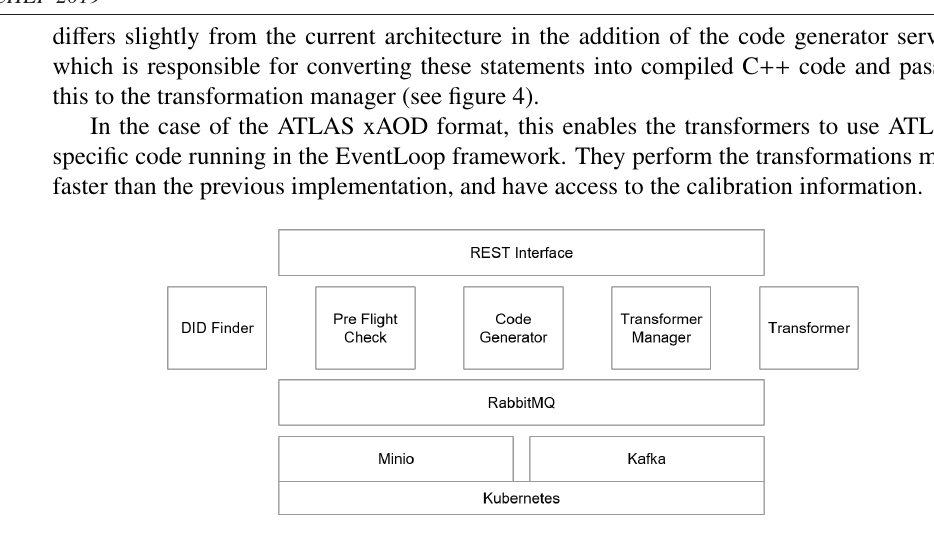
Figure 4. Architecture for ServiceX version